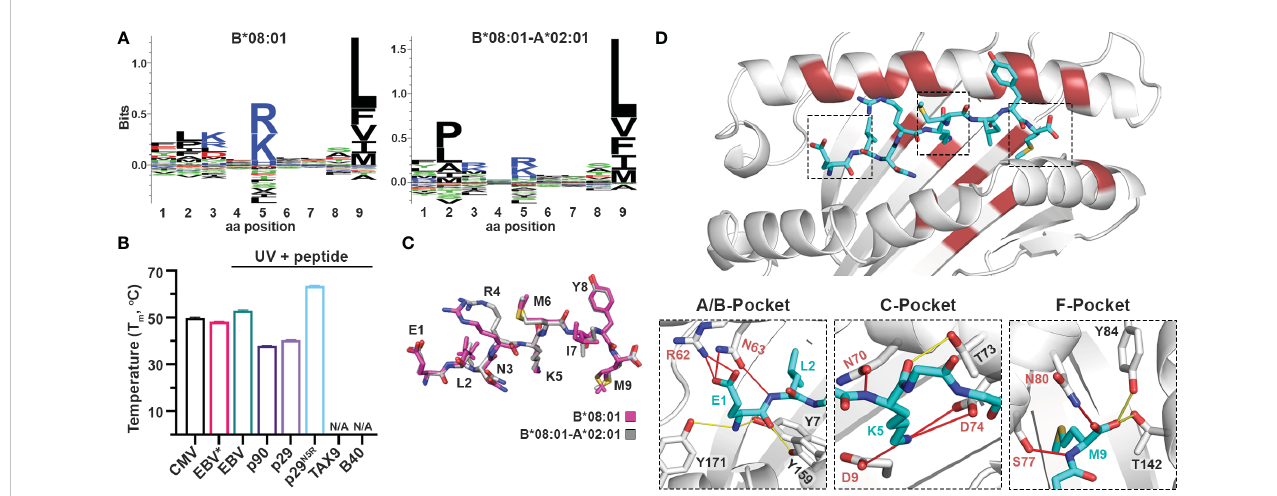
FIGURE 4 Introduction of a P5 anchoring speci fi city into the C-pocket of HLA-A*02:01 using a B*08:01 structural template. (A) The sequence logos of the HLA- B*08:01 (left), and B*08:01-A*02:01 (right) rendered using an in-house method and visualized in Seq2Logo from the NetMHCpan4.0 (40). (B) Thermal stabilities of HLA-B*08:01-A*02:01 refolded with CMV (ELNRKMIYM) or EBV* (FLRGRAJGL, where J is the 3-amino-3-(2-nitrophenyl)-propionic acid) and after UV-irradiation in the presence of 10-fold molar excess of EBV, p90, p29, p29 N5R , TAX9, and B40 peptides. Data are mean ± SD obtained from n = 3 technical replicates. N/A, no exchange. (C) Overlay of the CMV peptide bound to the chimeric B*08:01-A*02:01 (grey) and wild-type B*08:01 (magenta) molecules. (D) Crystal structure of HLA-B*08:01-A*02:01/CMV complex where substitutions of the groove residues are highlighted in red. Hydrogen bonds and salt bridges between the peptide and the base or groove allele residues are shown as yellow or red lines, respectively. Peptide, A*02:01- speci fi c, and B*08:01-speci fi c residues are labeled in cyan, black, and red font,